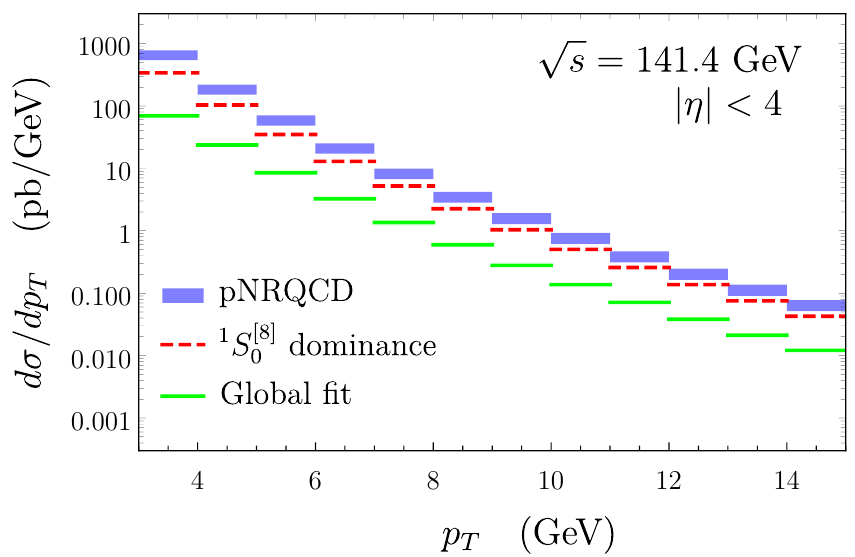
Figure 17 . The pNRQCD prediction for the p T -differential cross sections for J/ψ from ep collisions at the EIC with center of mass energy comparison, predictions based on the 1 S [8] ref. [40] are also